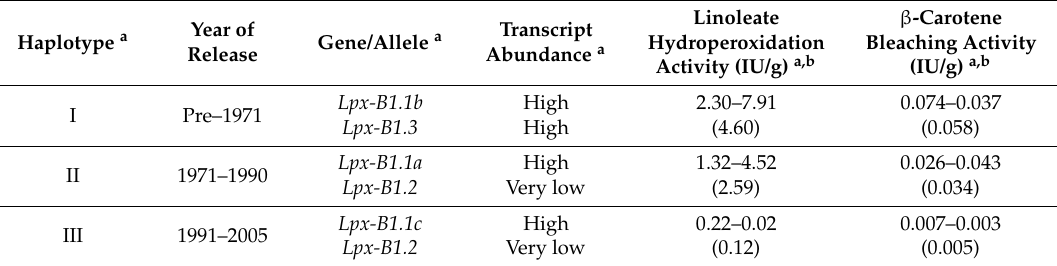
Table 4. Molecular and biochemical characteristics of the three Lpx-B1 haplotypes in durum wheat germplasm.